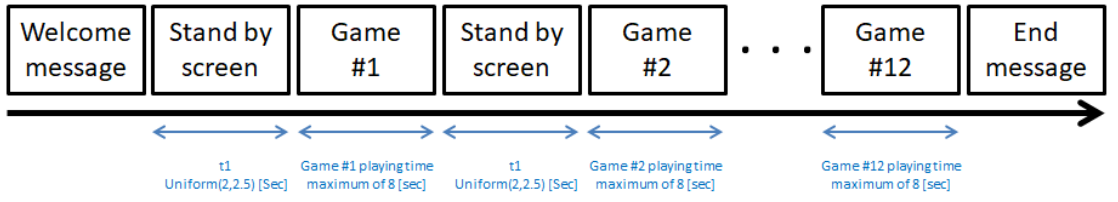
Figure 2. Experimental paradigm with timeline.